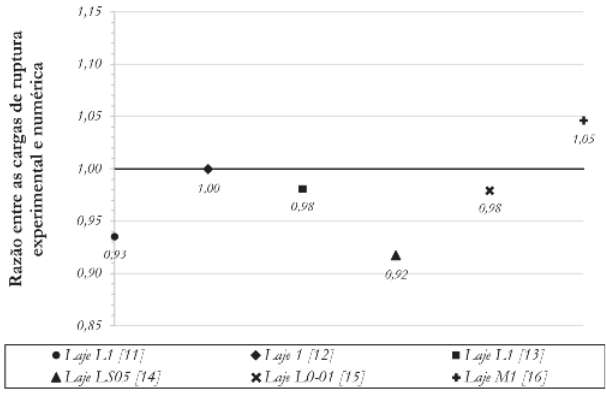
Figura 2 Razão entre as cargas de ruptura experimental e numérica das lajes lisas adotadas para a validação do modelo